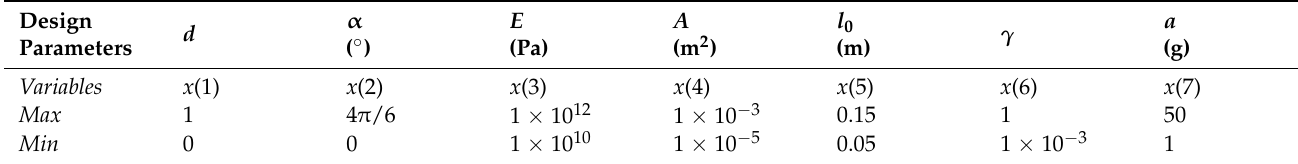
Table 1. Domain intervals of design